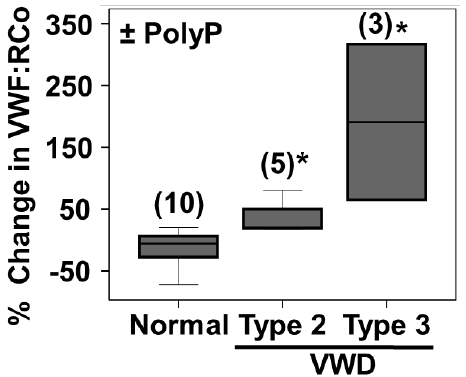
Figure 6. PolyP addition increases the von Willebrand factor ristocetin co-factor activity in plasmas from patients with von Willebrand disease type 2 and 3. Experiments were performed as described in Figure 3 but using plasmas from healthy individuals (Normal) and patients with von Willebrand disease type 2 (Type 2 VWD) and type 3 (Type 3 VWD). Quantification of the differences in von Willebrand factor ristocetin co-factor activity after the addition of 2.5 µM of isolated polyphosphate (polyP 65 ). Results are presented in a box-and-whiskers plot. An asterisk indicates a statistical difference of p < 0.01, determined by Mann–Whitney test. Numbers of individuals in each category are indicated in parenthesis. Measurements were performed using an automated aggregometer (Helena AggRAM).